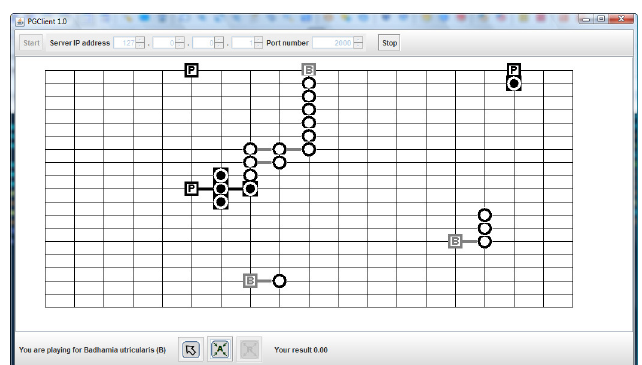
Figure 9: The main window of